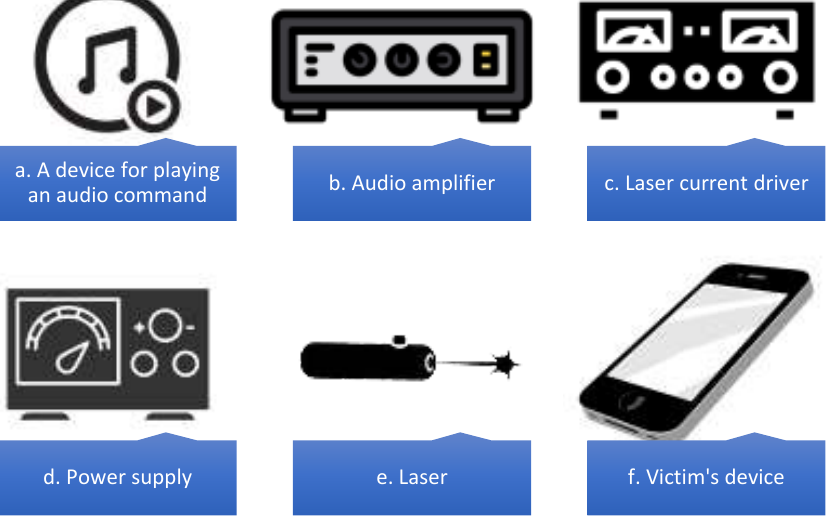
Figure 6. Equipment needed.